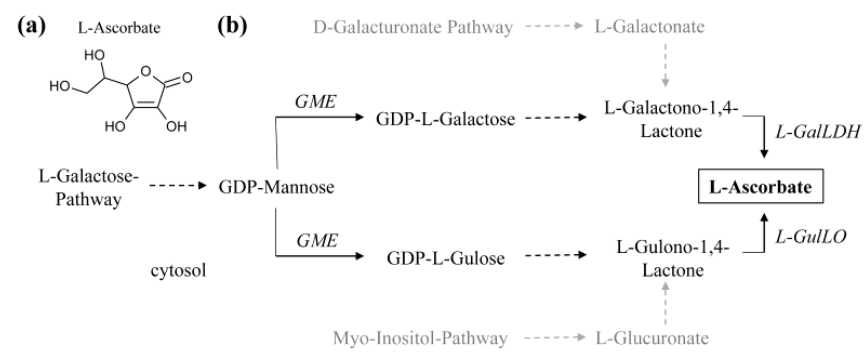
Figure 4. Ascorbate biosynthesis in higher plants. ( a ) Chemical structure of L-ascorbate. ( b ) Two alternative pathways, the D-galacturonate and the myo-inositol pathways, may contribute to L- ascorbate biosynthesis via L-galactonate and L-glucuronate, respectively, entering the L-galactose pathway. However, because hard proof for the existence of either pathway is missing for plants, the D-galacturonate and myo-inositol pathways are shown in light grey. L-GulLO, L-gulono-1,4-lactone oxidase; L-GalDH, L-galactose dehydrogenase; GDP-mannose epimerase (GME). Dashed arrows indicate multiple steps in between two